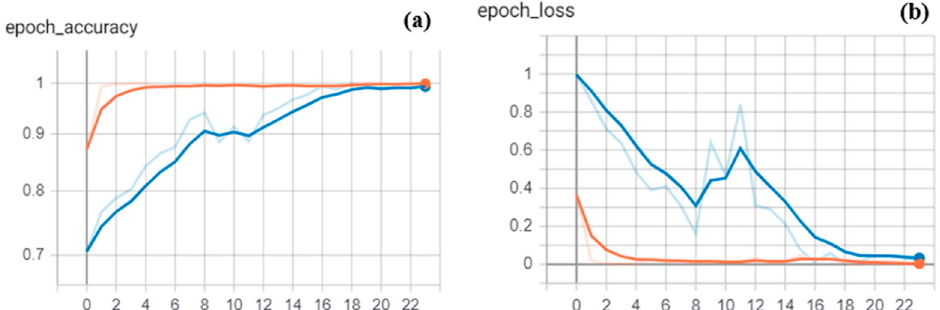
Figure 4. Tensorboard diagrams of accuracy ( a ) and loss ( b ) on the training and validation dataset, respectively orange and blue, over training epochs. The training and validation accuracy gradually increase to around 1, whereas the training and validation loss converges to 0.01 after 23 epochs. Overfitting does not occur during the training.